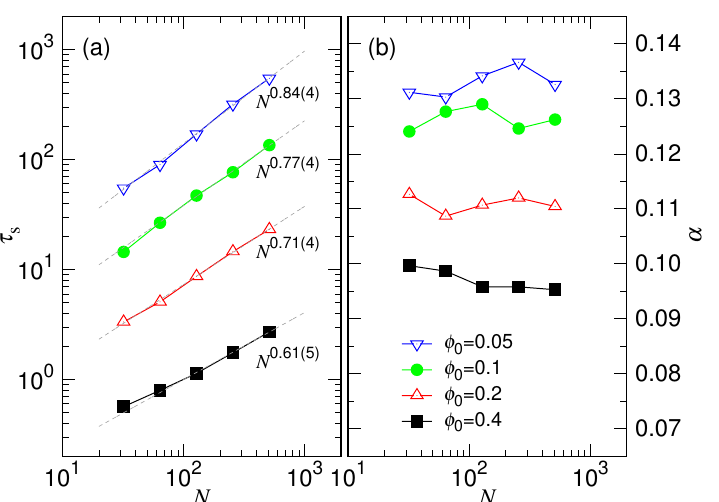
Figure 14. ( a ) τ s vs. N and ( b ) α vs. N for different φ 0 . The value of φ 0 can be read in the legend of Panel ( b